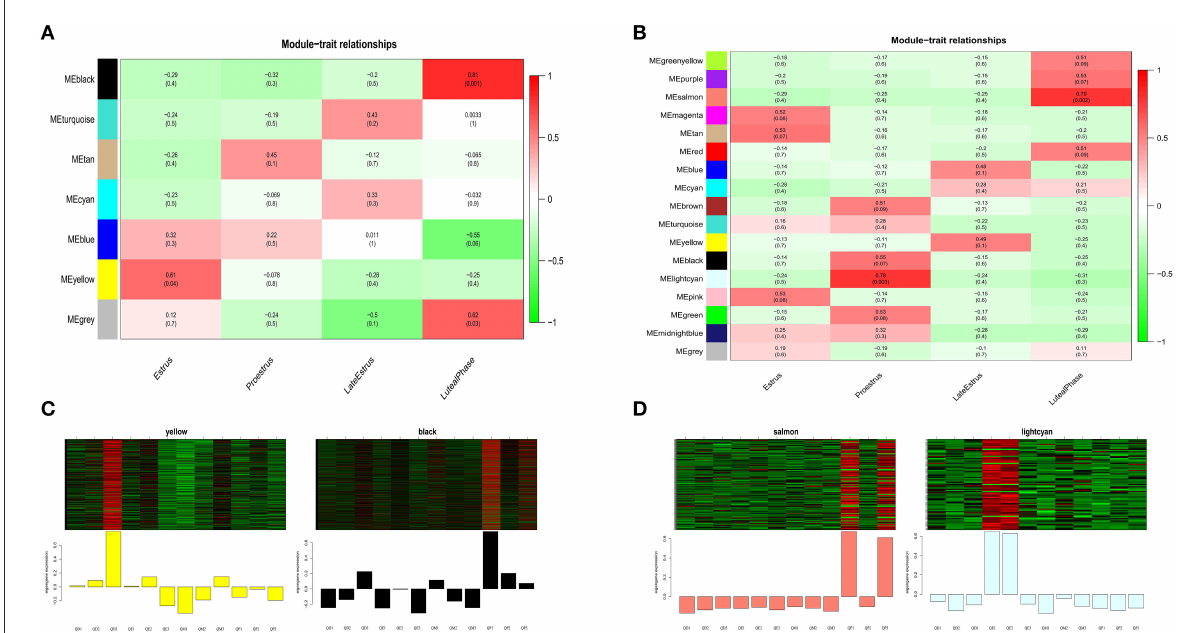
FIGURE8 Key module analysis. mRNA module-feature relationships (A) , and LncRNA module-feature relationships (B) , The number of each grid indicates the module-feature correlation, and the number in parentheses indicates the p-value. (C) Heat map gene expression patterns of mRNA key modules. (D) LncRNA key modules. The upper panel shows the heat map of gene expression in modules in different samples, and the lower panel shows the expression pattern of module feature values in different